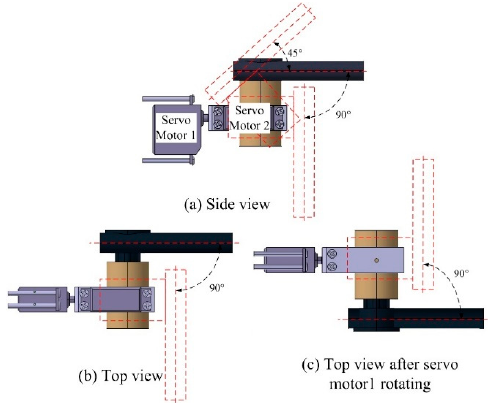
Figure 8. The nozzle angle of different motion states.